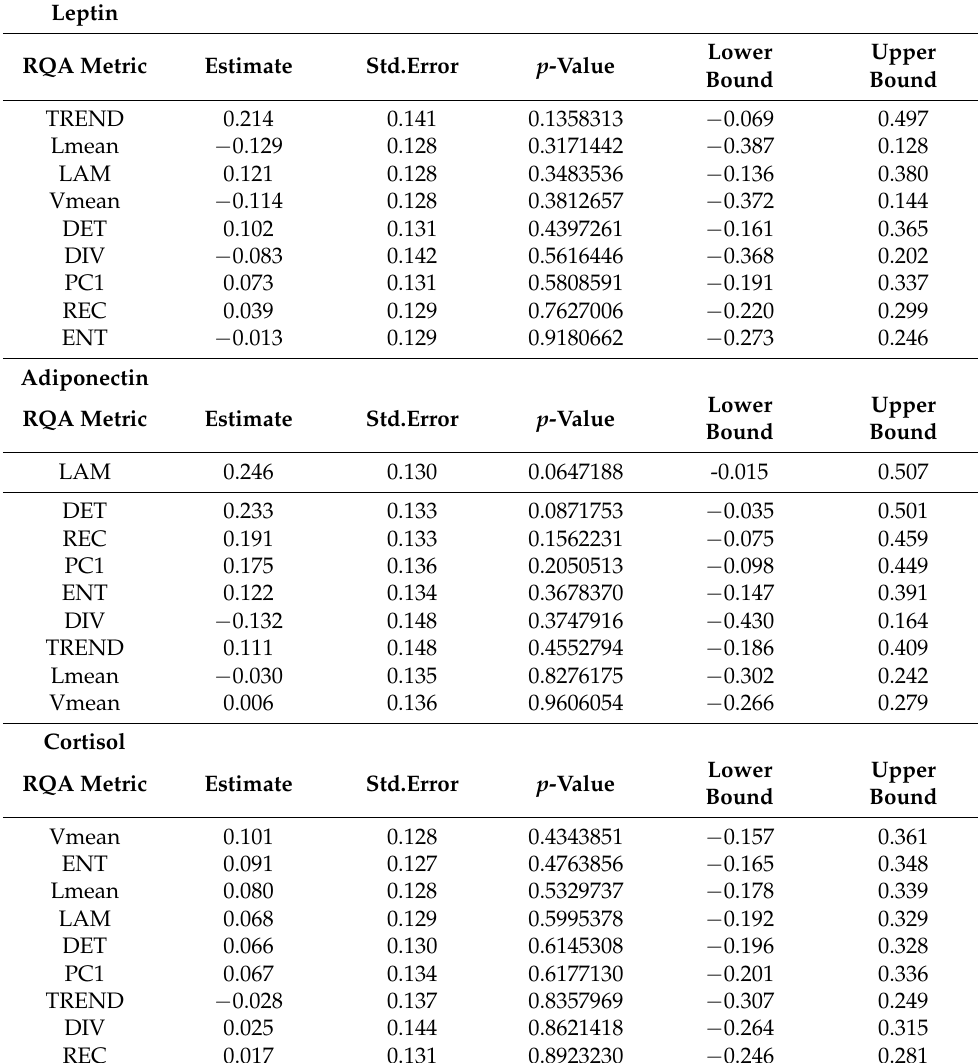
Table 3. Linear mixed-effect models of log-transformed biomarkers (leptin, adiponectin and cortisol) as a function of first morning sample (in comparison to the last-before-sleep sample) accounting for the repeated measurements and for